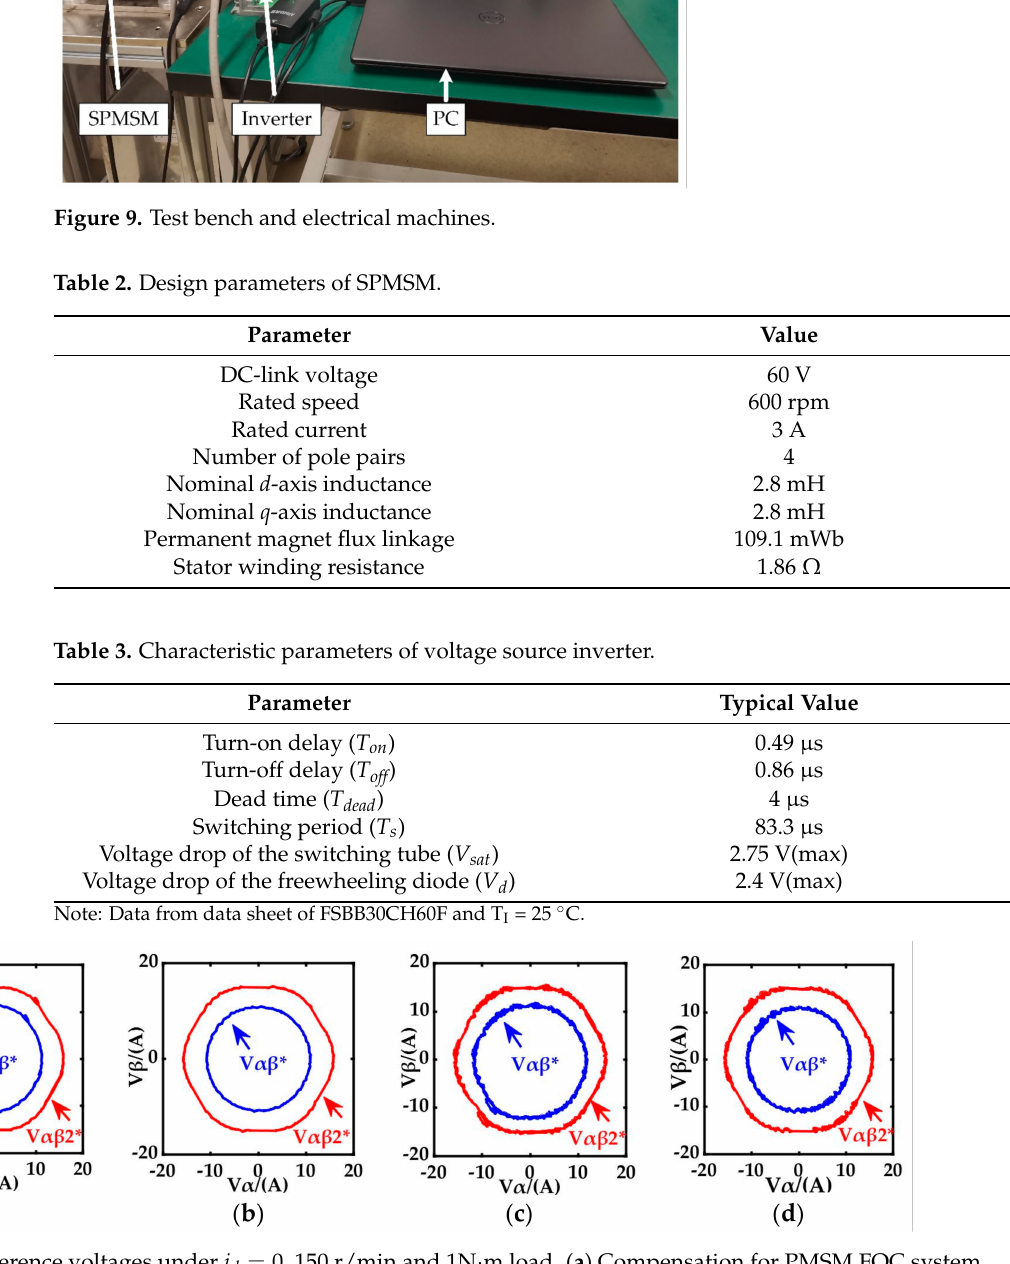
Figure 10. αβ –axis reference voltages under i d = 0, 150 r/min and 1N · m load. ( a ) Compensation for PMSM FOC system with conventional DM–CZD. ( b ) Compensation for PMSM FOC system with proposed DP–CZD. ( c ) Compensation for current predictive control of PMSM with conventional DM–CZD. ( d ) Compensation for current predictive control of PMSM with proposed